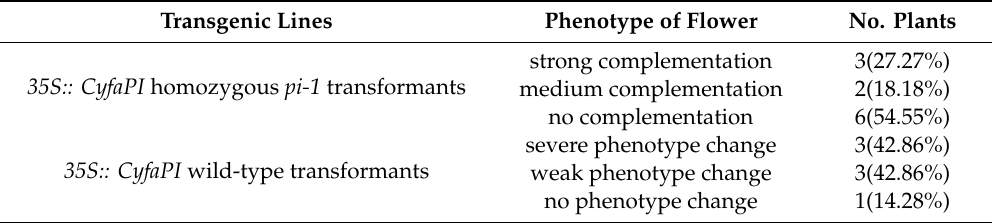
Table 1. Summary of di ff erent phenotypes of transgenic